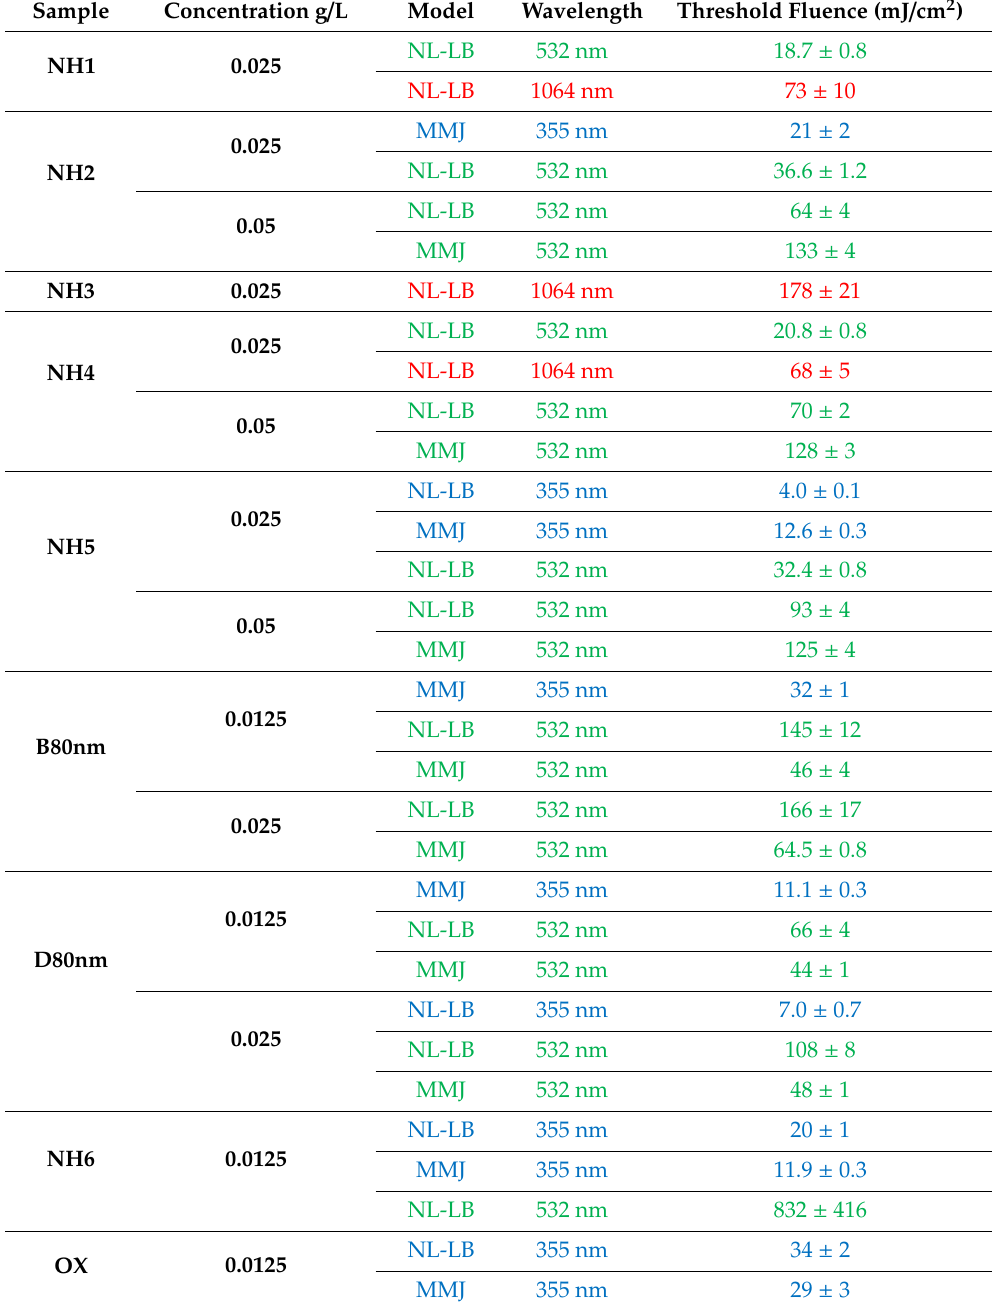
Table 4. Fluence threshold values obtained from